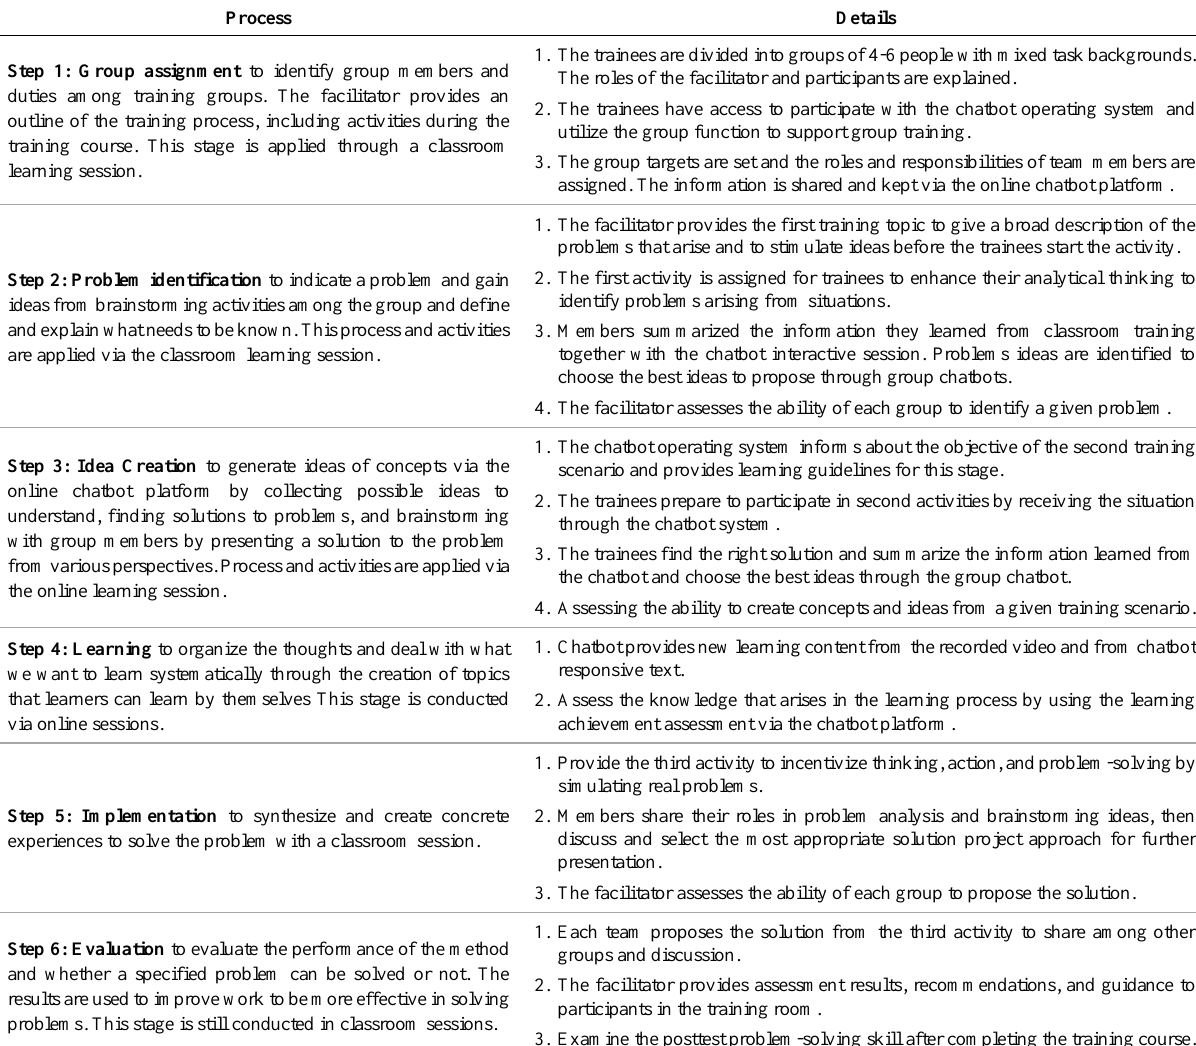
Table 4. The instruction process of a problem-based blended training model to enhance problem-solving skill in the workplace Process Details